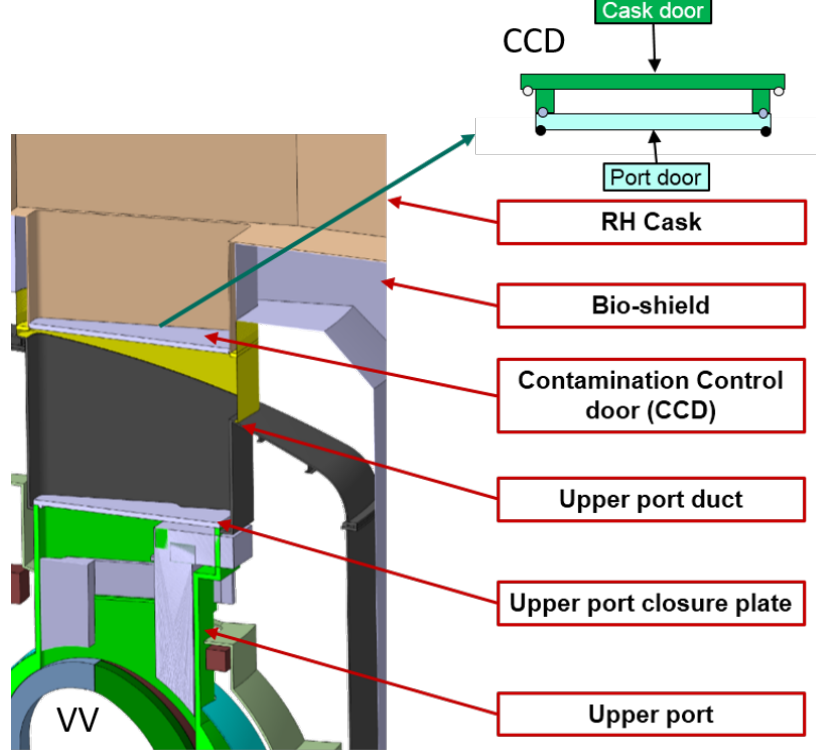
Figure 1. A RH cask docks to the upper port duct.